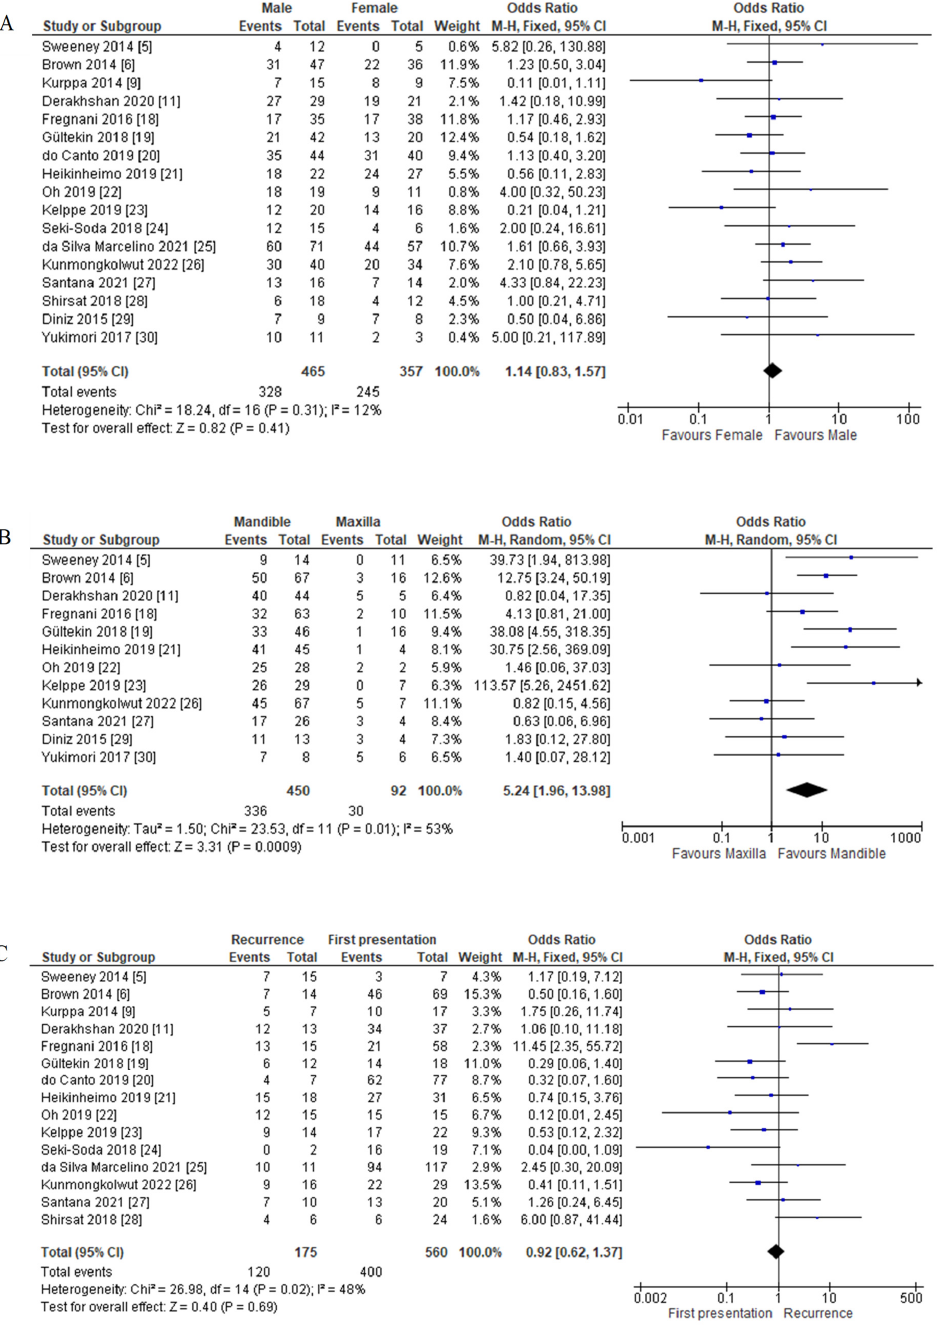
Figure 5. Forest plot of clinicopathological features association with BRAF V600E mutation in ameloblastoma cases. ( A ) Sex with BRAF V600E mutation; ( B ) tumour location with BRAF V600E mutation; ( C ) recurrence with BRAF V600E mutation.